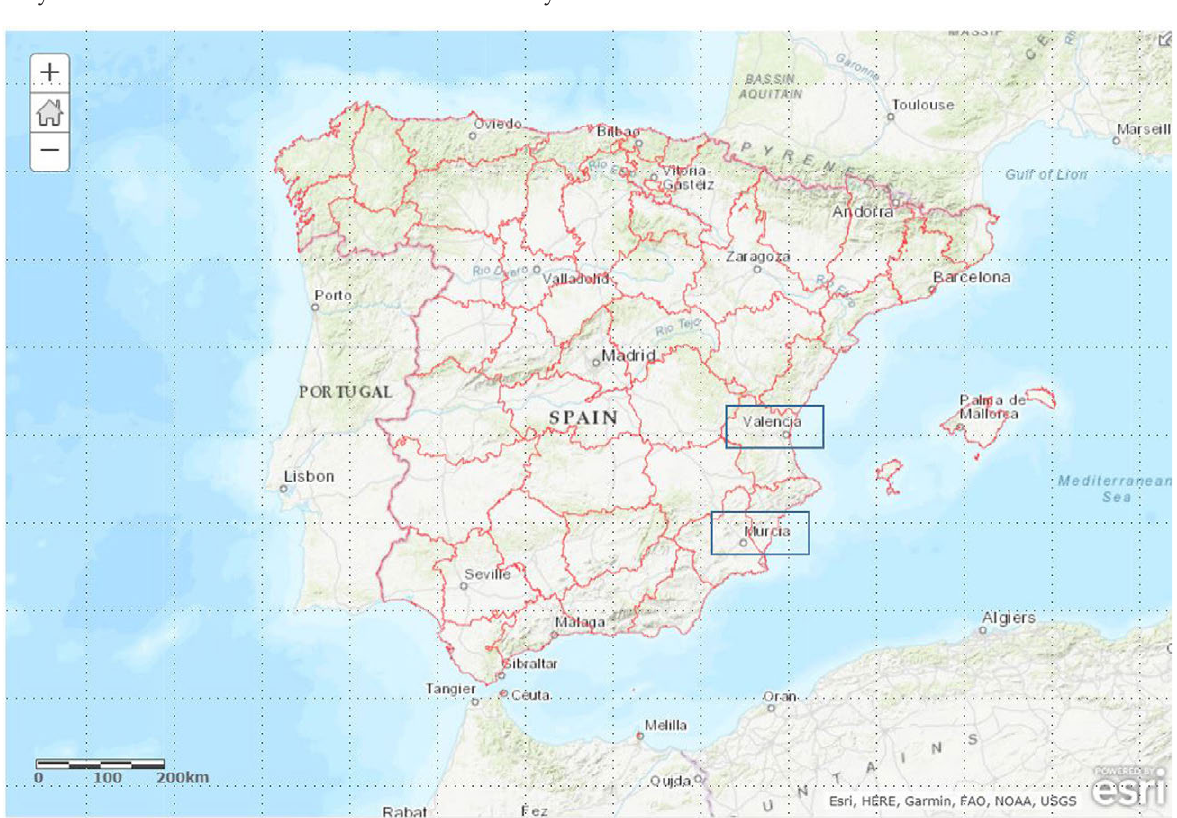
Fig. 1. Location of Murcia and